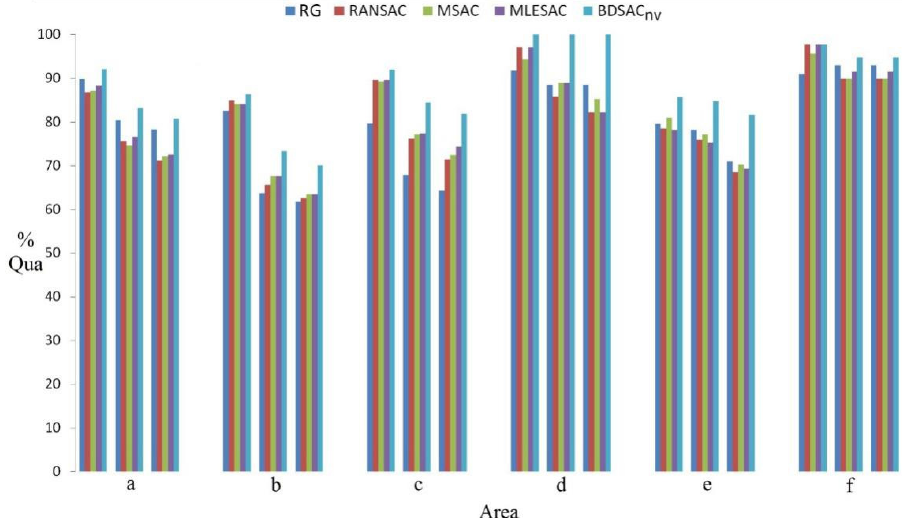
Figure 11. Quantitative results of the Vaihingen data. ( a – f ) are the six areas selected in Figure 10. Three metrics are used, from left to right: quality of segmentation and quality of two ridge based metrics.